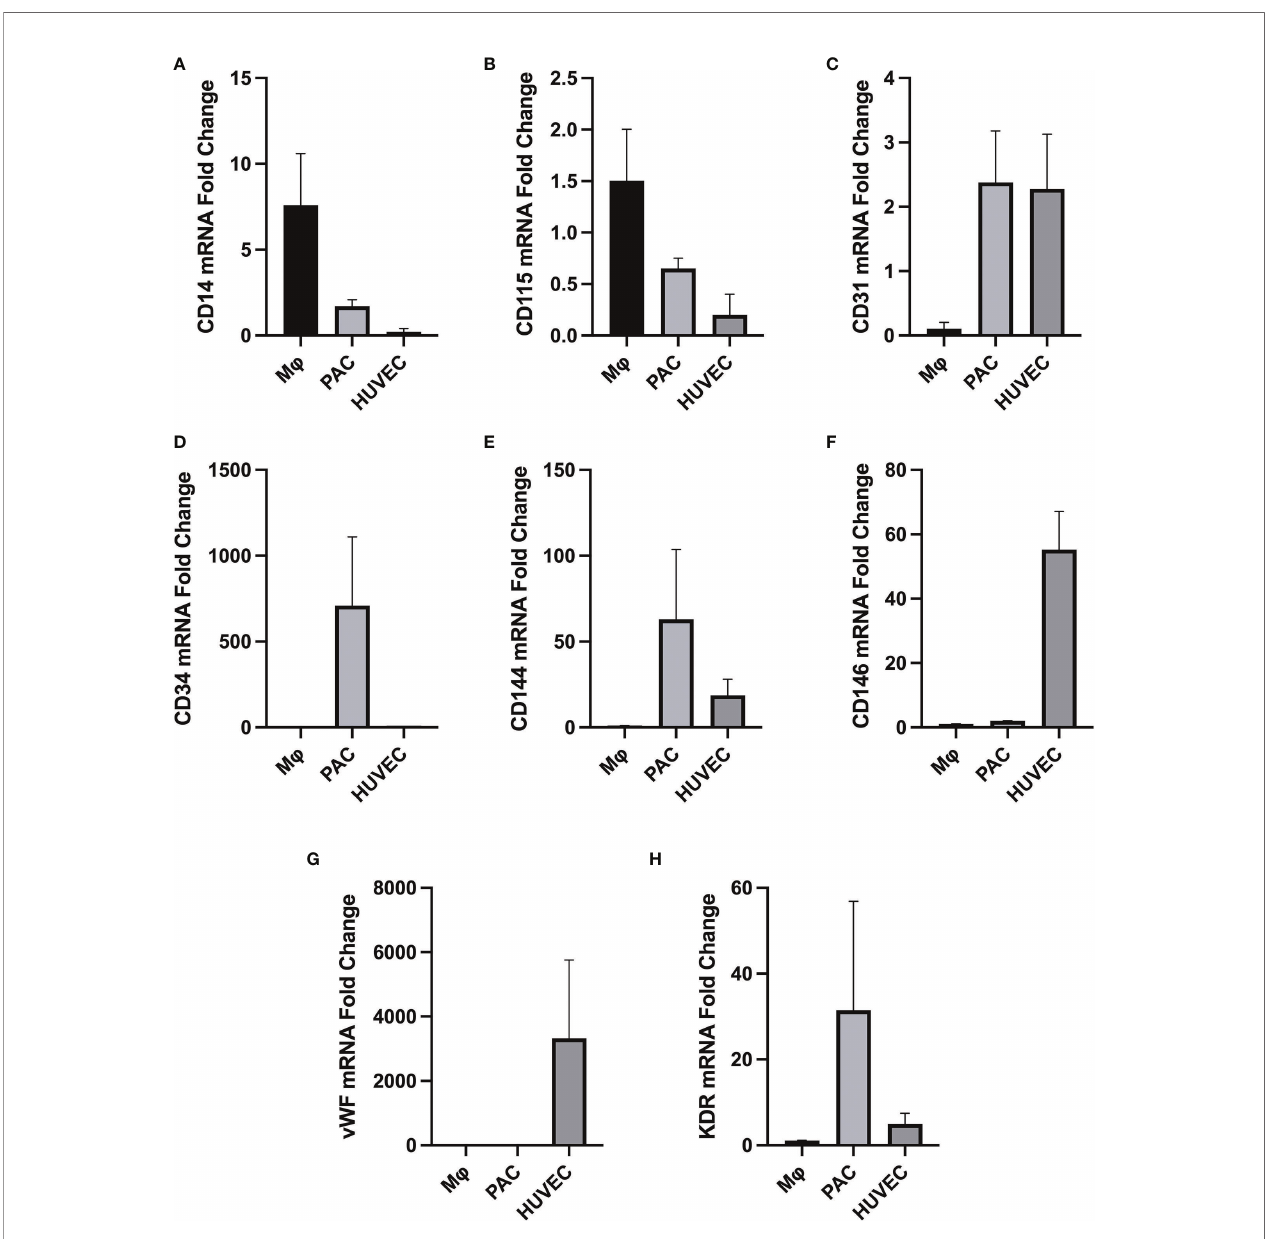
FIGURE 1 | Differential gene expression (analyzed by RT-qPCR) in macrophages (M Ф ), PACs, and human umbilical vein endothelial cells (HUVEC), all isolated from the same donor ( n = 3). Gene expression of macrophage-speci fi c markers (A) CD14 and (B) CD115. (C) Gene expression pro fi le of endothelial cell surface marker CD31. (D) Gene expression of the hematopoietic stem cell surface marker CD34 in PACs. (E) CD144 (VE-cadherin) is expressed in endothelial cells but not in macrophages. (F) CD146 (melanoma cell adhesion molecule) cell adhesion molecule used as a marker for mature endothelial cell lineage. (G) Gene expression of endothelial cell-speci fi c marker vWF, upregulated in mature endothelial cells but not in PACs and macrophages. (H) KDR vascular endothelial growth factor receptor 2 (VEGFR-2), which is highly expressed in endothelial cells HUVECs and PACs. HUVECs serve as a control cell type for comparison. All data were normalized to the reference gene TATA-box-binding protein (TBP). It appears that PACs are distinctively different from macrophages given their characteristic gene